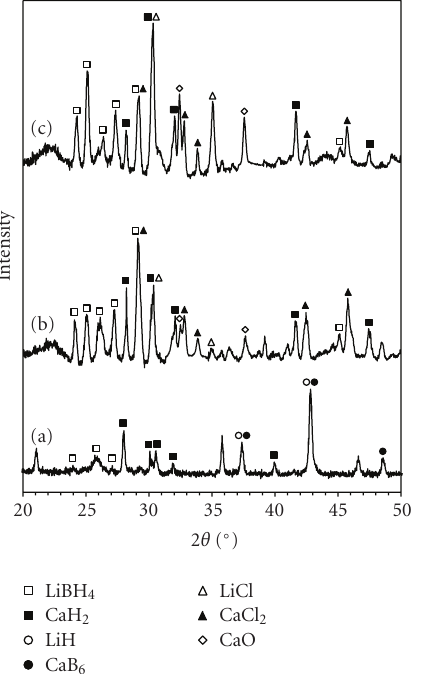
Figure 5: XRD patterns of the rehydrogenated LiBH 4 /CaH 2 mix- ture with a di ff erent amount of TiCl 3 additive: (a) none, (b) 4mol%, and (c) 25mol%.